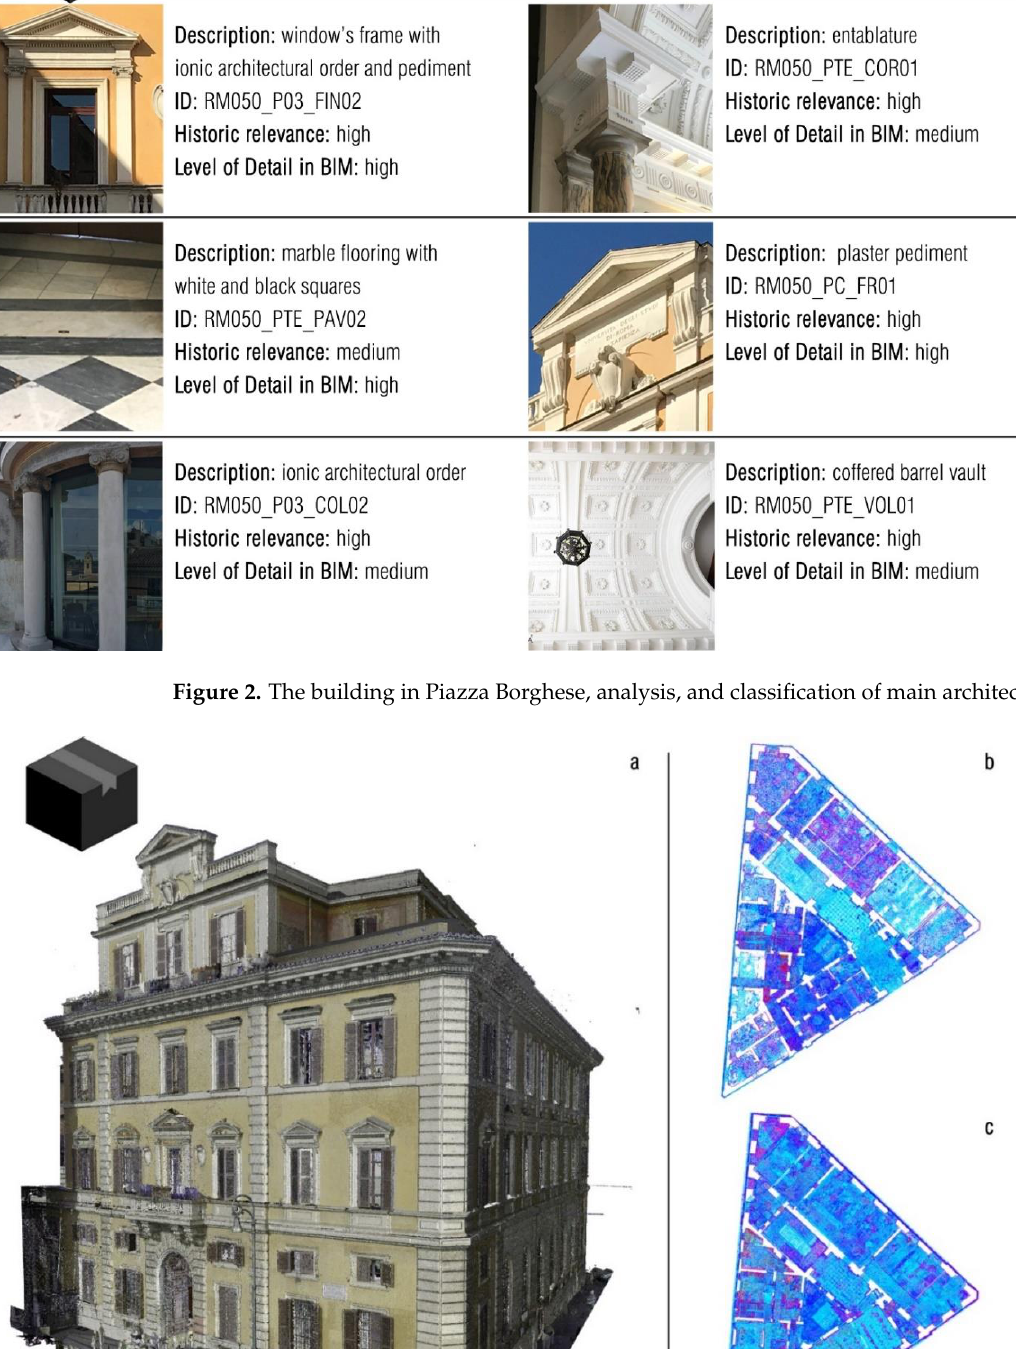
Figure 3. ( a ) The building in Piazza Borghese, point cloud. ( b ) Planimetric view of the building ground floor, point cloud. ( c ) Planimetric view of the building first floor, point cloud.